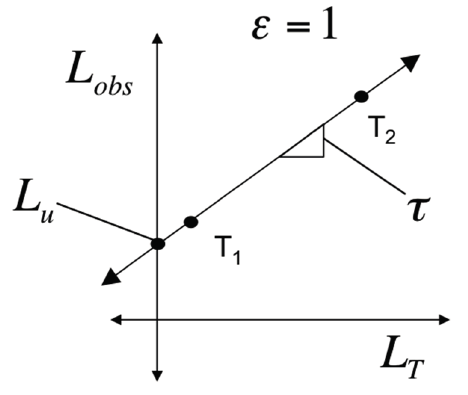
Figure 10. Illustration of regression to calculate transmission and upwelled